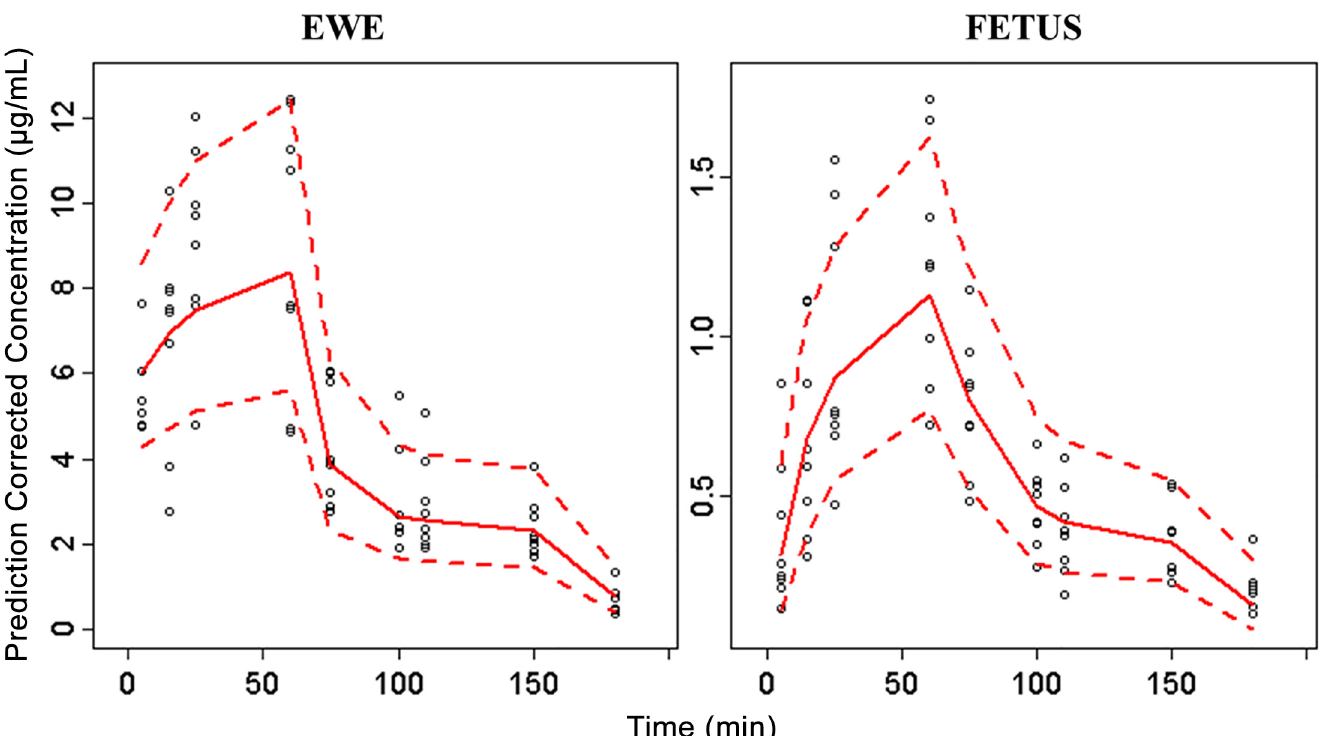
Fig 6. Visual predictive check of prediction-corrected concentration of propofol in ewe and fetus for the final model. Circles demonstrate prediction corrected observations. Red lines demonstrate 5th, 50th and 95th prediction percentiles.